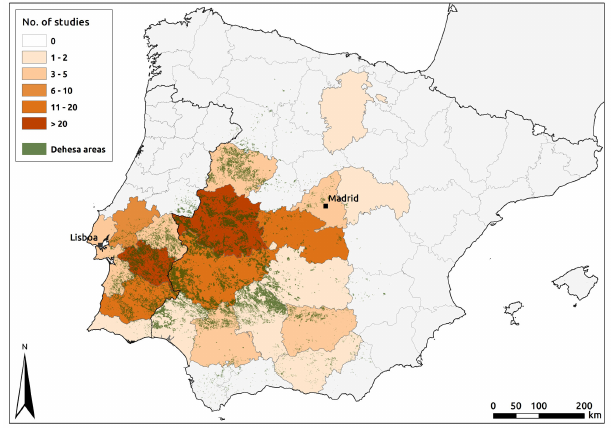
Fig. 4 . Distribution of dehesas across the Iberian Peninsula (green) and number of studies conducted in each Spanish province / Portuguese district (sources: CORINE Land Cover, European Environment Agency, Eurostat).